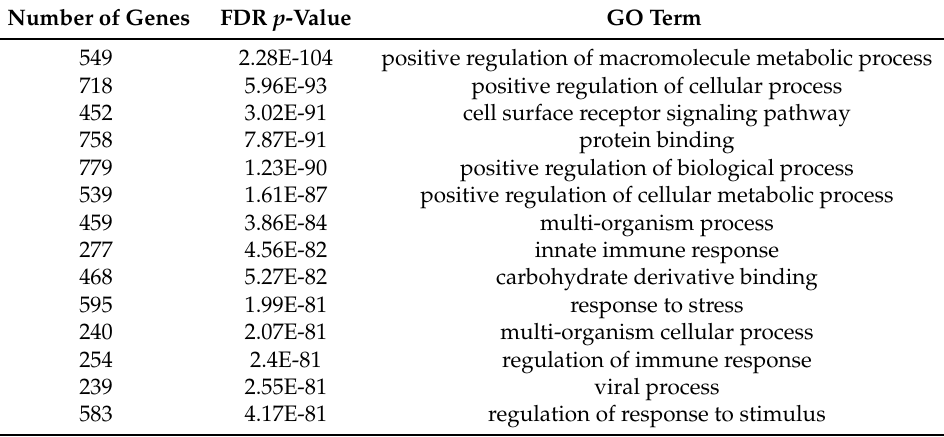
Table 1. Top gene ontology (GO) terms by false discovery rate (FDR) adjusted p -value that are enriched for the human proteins that interact with any virus